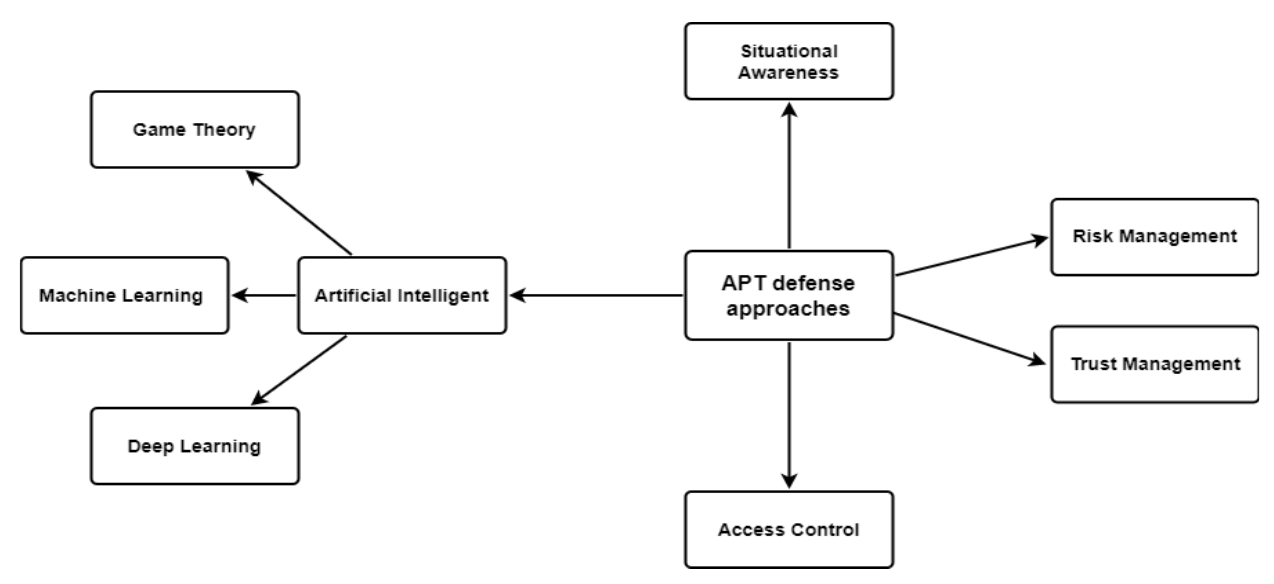
Figure 8. APT defense approaches.